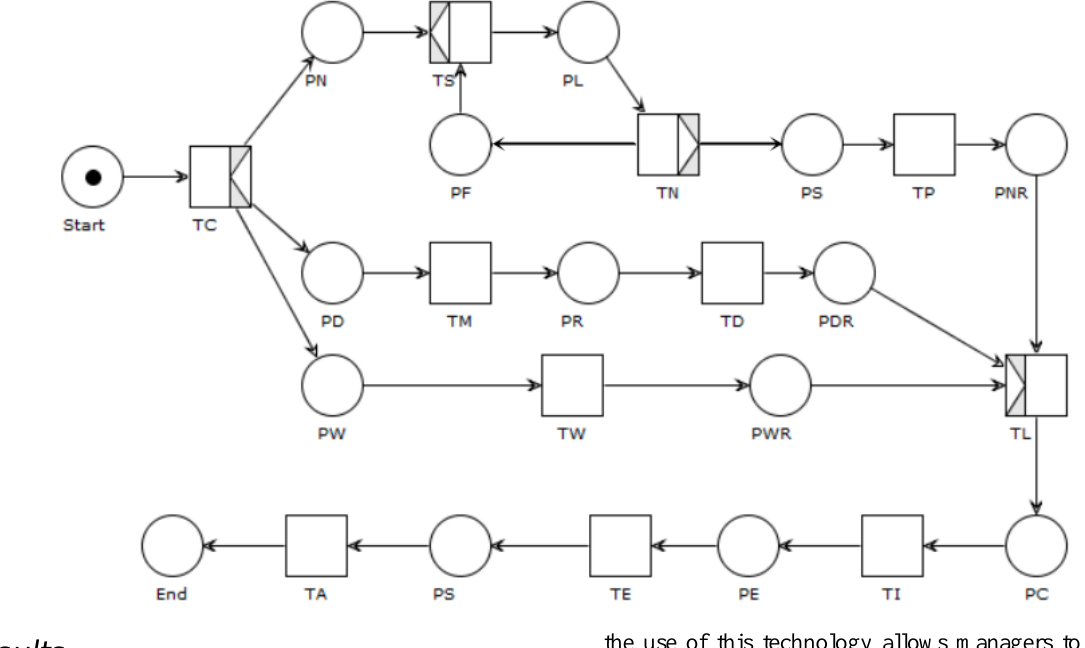
Figure 1. Framework of emergency material preparation and dispatch simulation system. PC: PC-BSD installer; PD: product department; PDR: